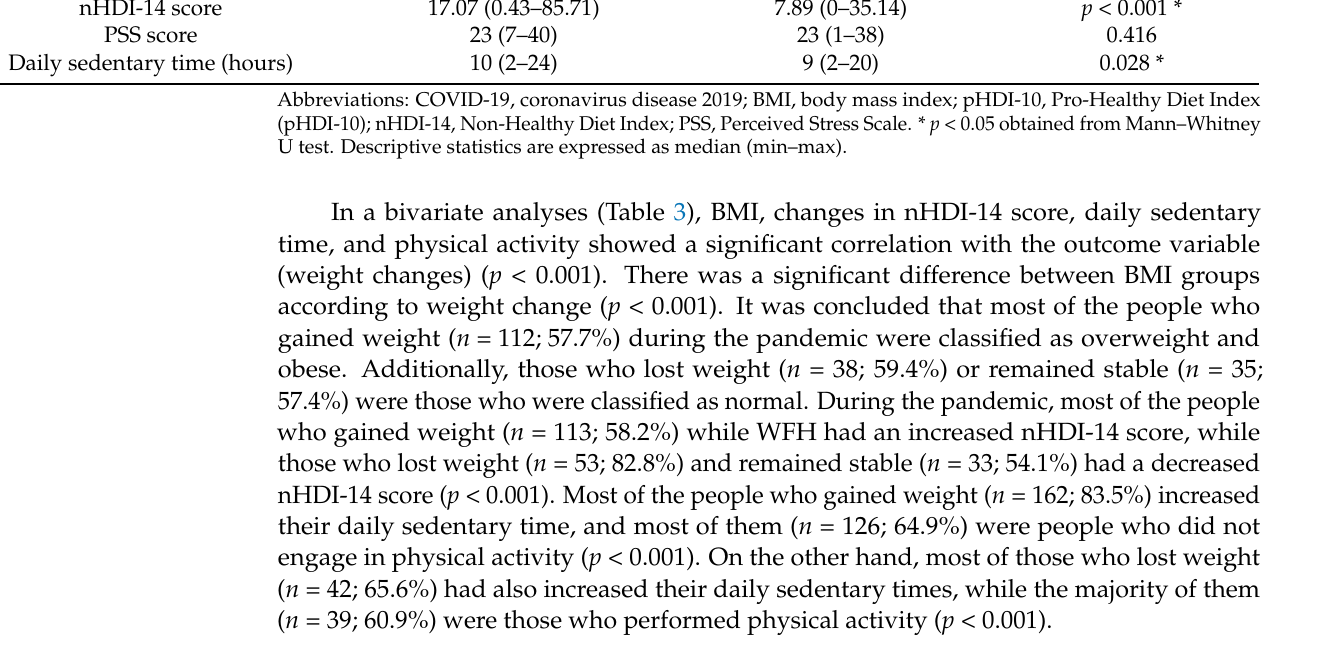
Table 3. Bivariate analyses of weight changes after WFH and potential predictor